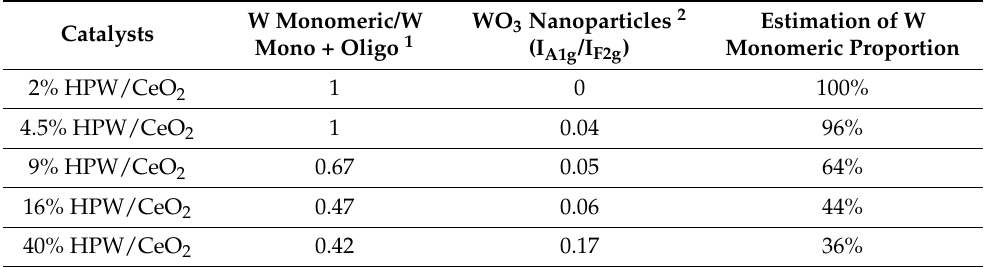
Figure 3. Raman spectra of CeO 2 , H 3 PW 12 O 40 , HPW/CeO 2 (2, 4.5, 9, 16, and 40 wt% W) ( a ) and enlarged image of tungsten species at 650–1000 cm − 1 ( b ). Table 2. Structure parameters of HPW/CeO 2 (2, 4.5, 9, 16, and 40 wt% W) catalysts.